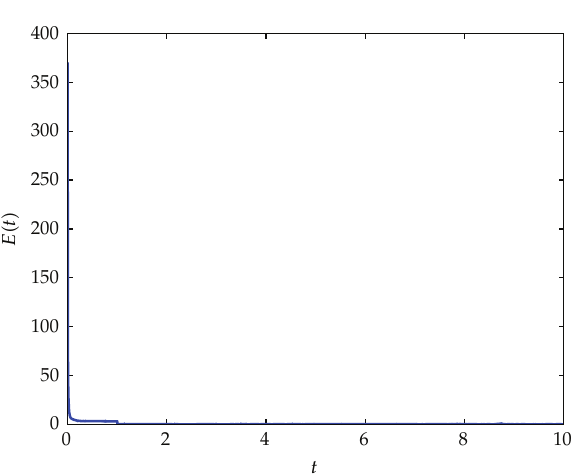
Figure 1: Time evolution of the synchronization errors E (cid:6) t (cid:7)